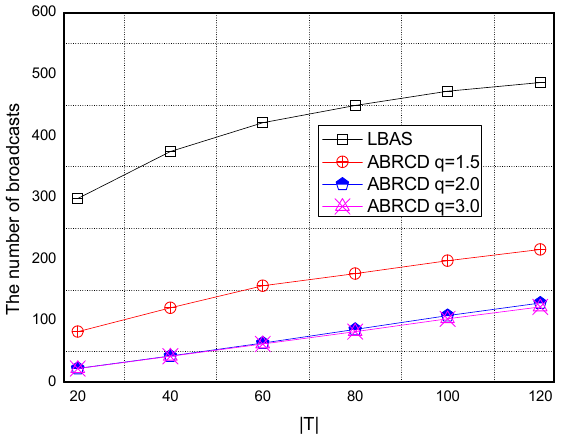
Figure 29. The impact of | T | with fixed network size = 600 on the number of broadcasts. Sensors 2018 , 18 , x FOR PEER REVIEW